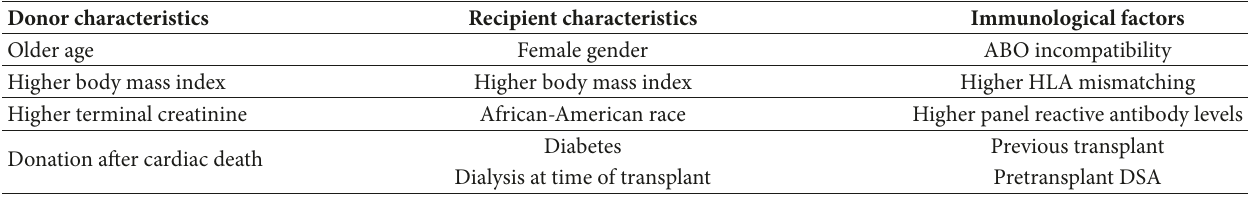
Table 1: Key risk factors for delayed graft function [1, 3,